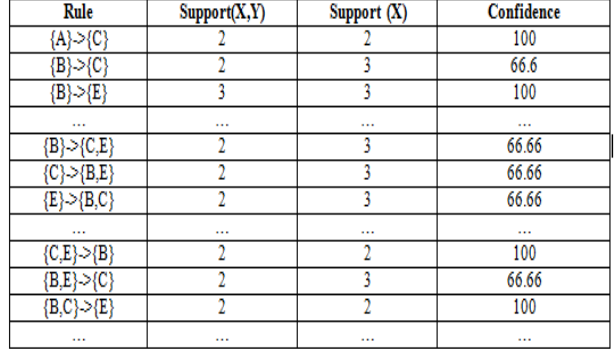
Figure 10. The demonstration shows how to generate the association